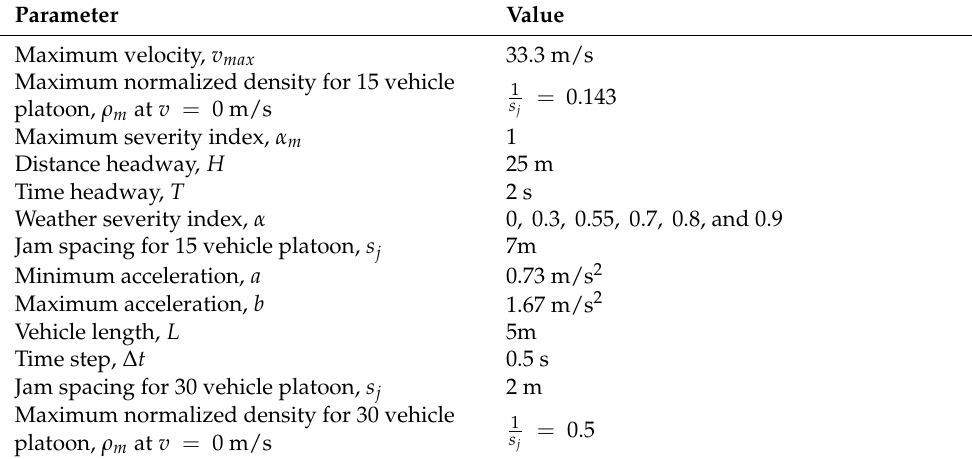
Table 2. Simulation